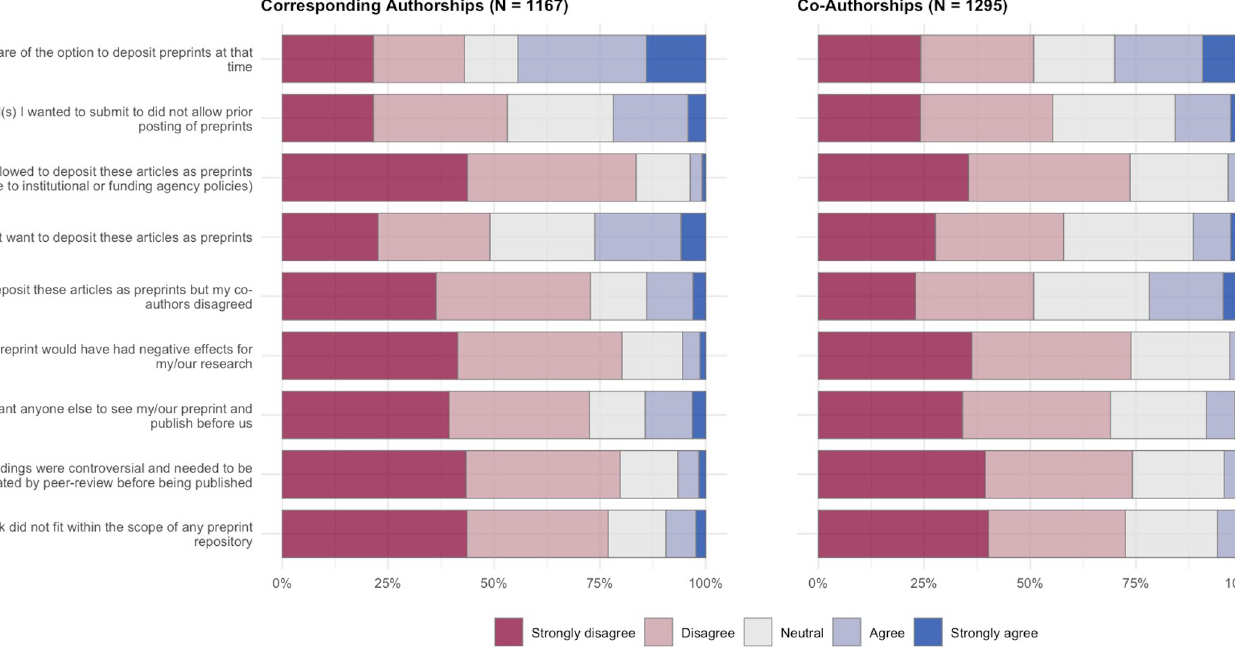
PLOS ONE | https://doi.org/10.1371/journal.pone.0274441 November3,